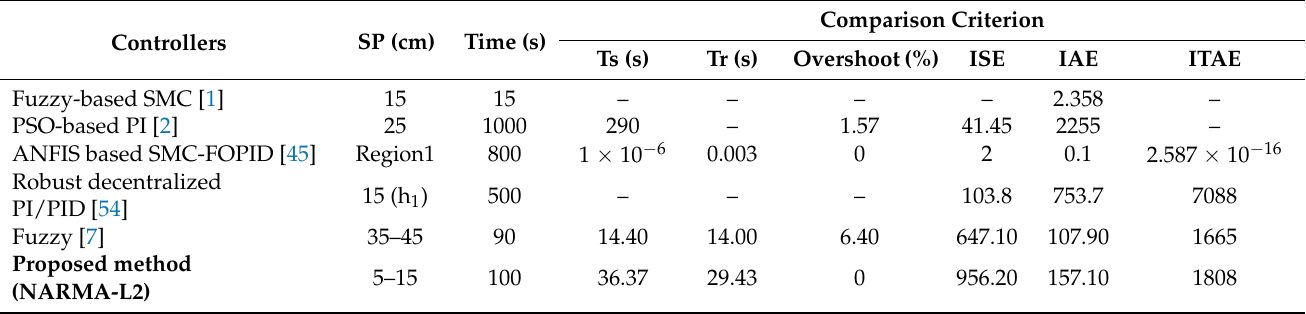
Table 10. Comparison between the performance of the controllers designed and results from other authors.